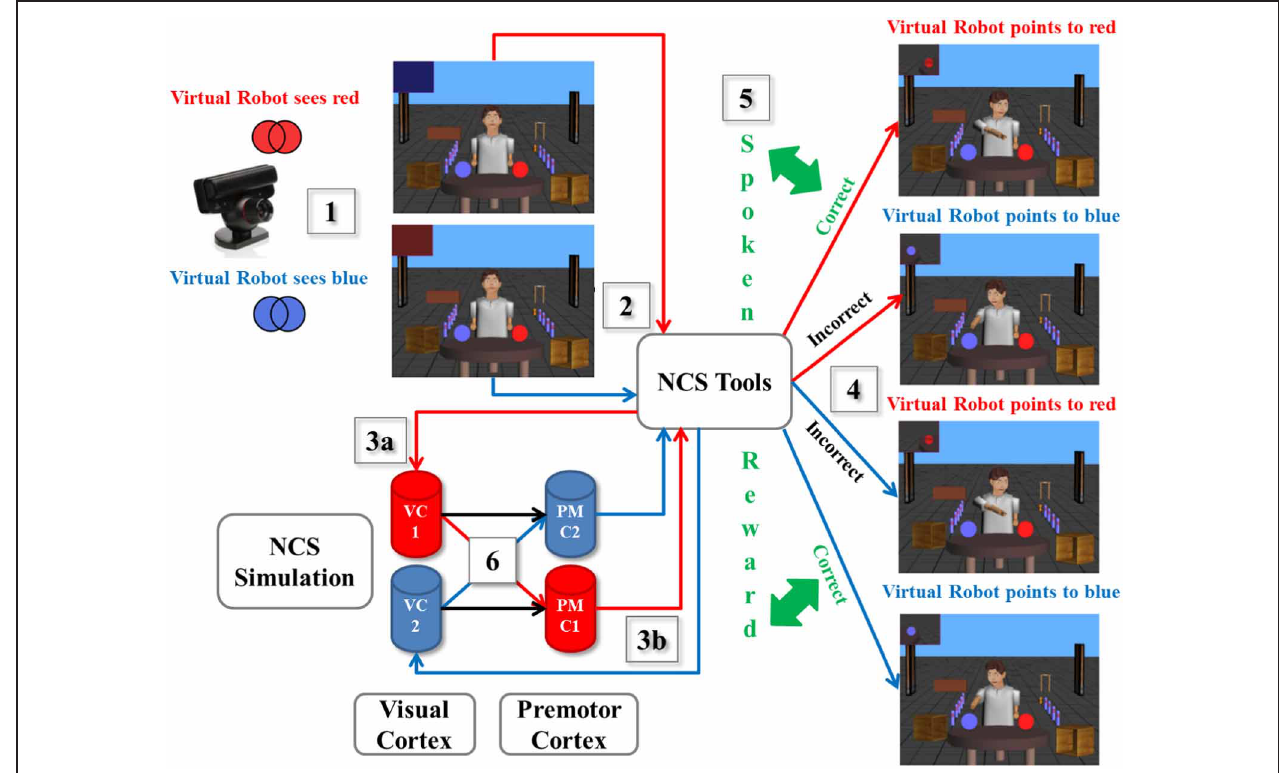
FIGURE 3 | A scenario of the virtual neurorobotic loop. (1) The external cue (red or blue card) is presented by the human to the neurorobot (via the camera); (2) The Information is processed by the neurorobot and is sent to NCSTools; (3a) NCSTools stimulates the appropriate regions of the modeled visual cortex; (3b) NCSTools server monitores the neurorobot and creates the appropriate stimulus to send to proprioceptive feedback and premotor movements; (4) This loop of events initiates the appropriate pointing motion/action toward a colored ball; (5) After the robot has pointed to the